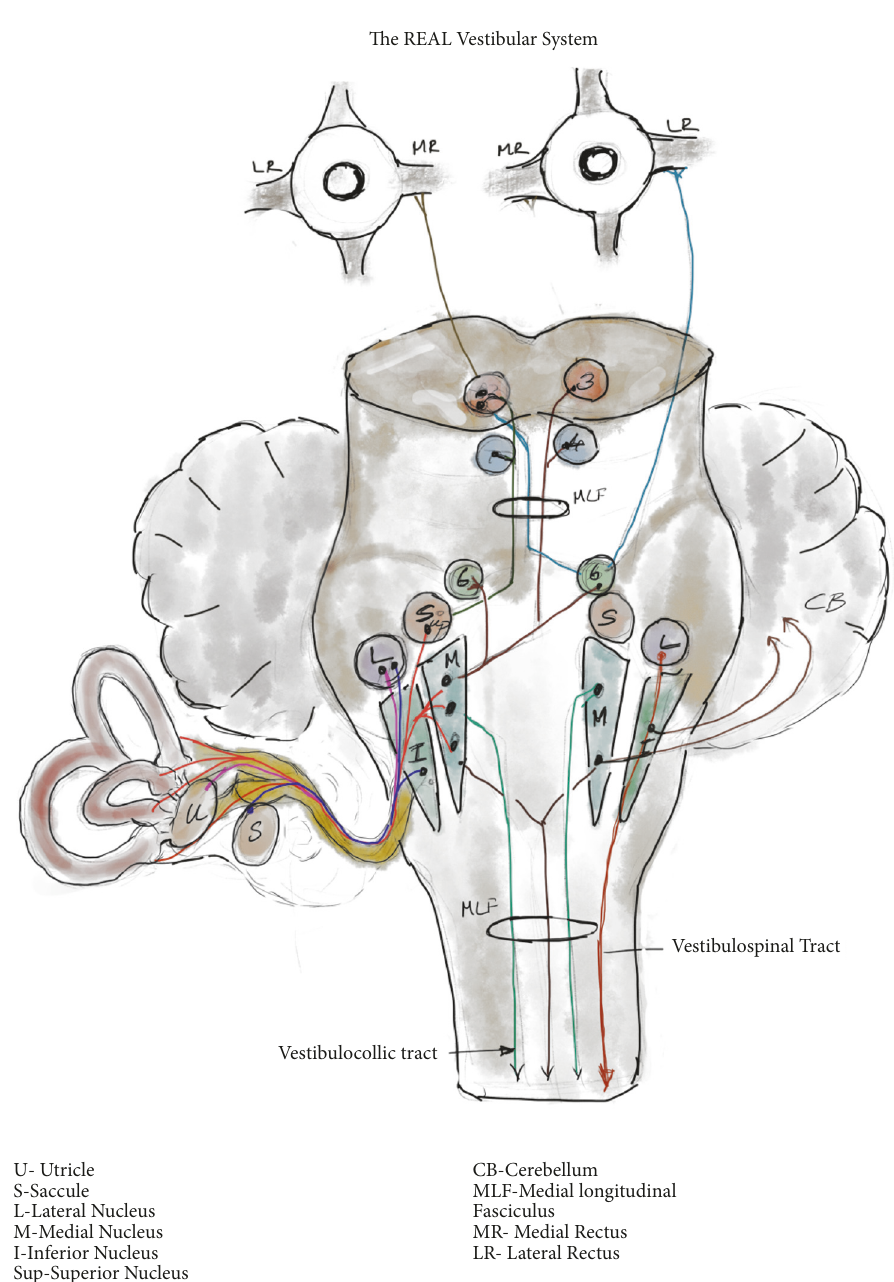
Figure 2: The real vestibular system. Impulses are carried from the horizontal semicircular canals and the otolith organs to the vestibular nuclei. Ascending and descending pathways that travel to various cranial nerve nuclei III, IV,VI are depicted here. Few fibers go directly to the cerebellum without synapsing in the vestibular nuclei. Ascending fibers travel through MLF to control ipsilateral and contralateral eye movements. Descending pathways travel to the neck and trunk through the vestibulocollic and vestibulospinal pathways to control neck and body positions to maintain